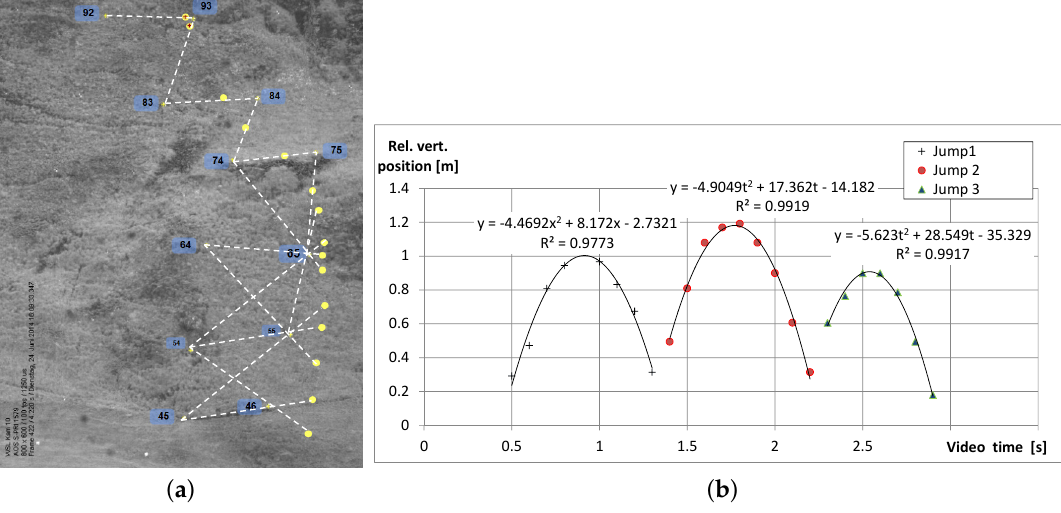
Figure 9. 2D video analysis: ( a ) targets along the slope were identified (blue squares) and connected pairwise as exemplified for Test 7. The block positions (yellow dots) and frame numbers were recorded where blocks crossed the connection lines (dashed lines). The position of blocks in the field was determined based on the conversion factor calculated from the distance between two targets; ( b ) the vertical pixel position of the block during–for example–Test 28 was tracked over time. The conversion factor from pixels to meters is calculated such that the vertical parabola corresponds to a free fall sequence, with gravity as constant